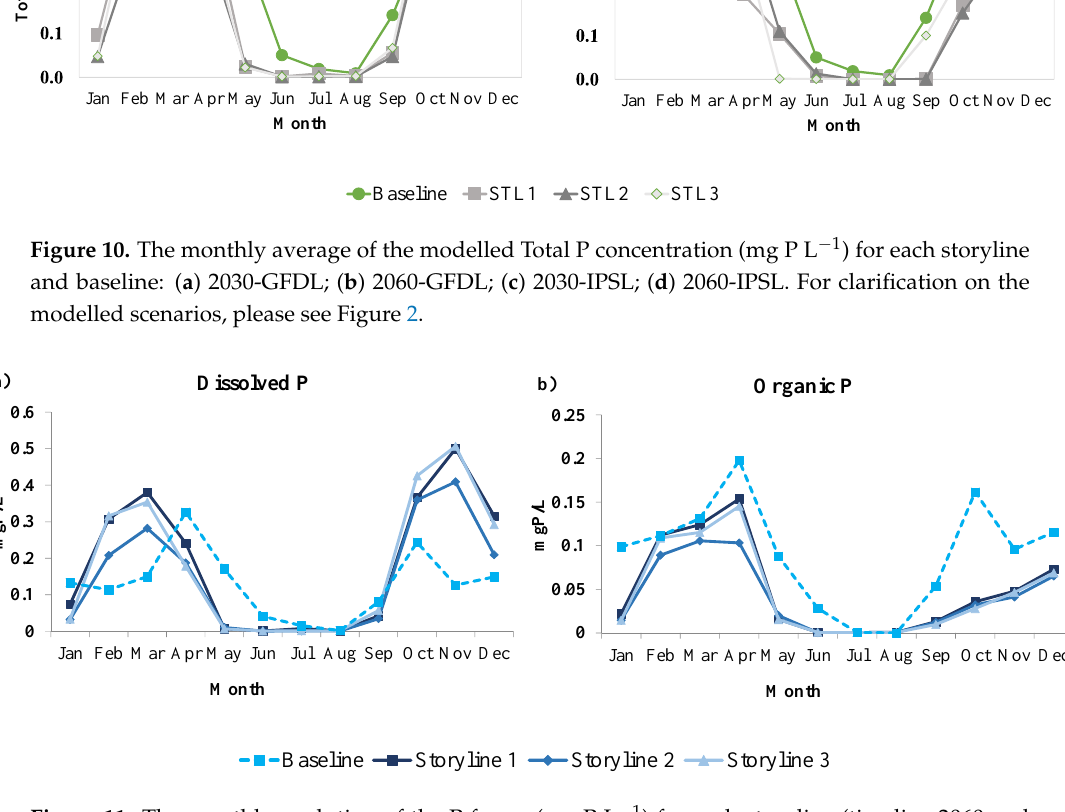
Figure 10. The monthly average of the modelled Total P concentration (mg P L − 1 ) for each storyline and baseline: ( a ) 2030-GFDL; ( b ) 2060-GFDL; ( c ) 2030-IPSL; ( d ) 2060-IPSL. For clarification on the modelled scenarios, please see Figure 2.